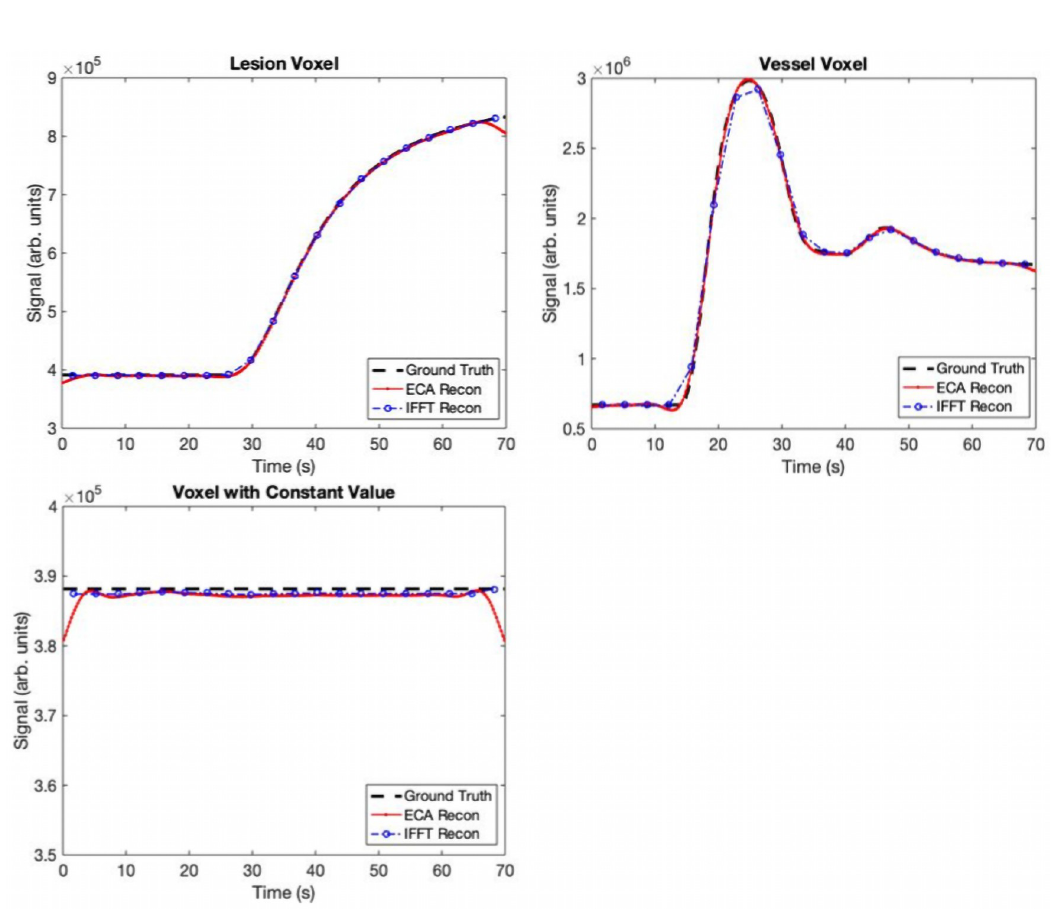
Fig 12. Comparison of sample signal curves from standard IFFT and ECA reconstruction. The ECA is more sensitive to noise than the IFFT, but the noise is still small with respect to the signal. IFFT reconstruction estimates bolus arrival time and peak signal less accurately than ECA